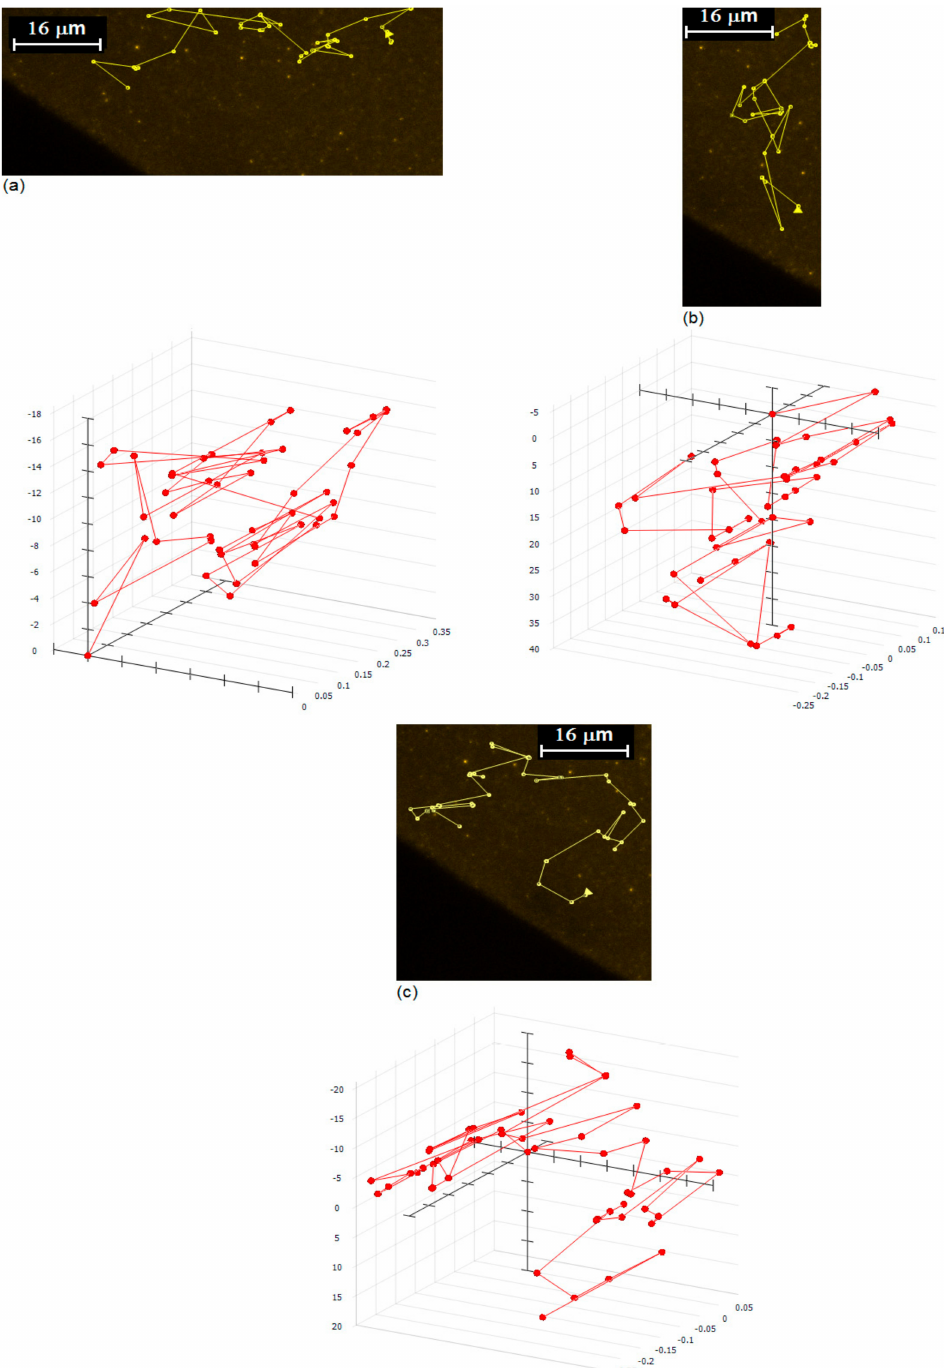
Figure 3. Two- (2D) and three-dimensional (3D) tracking of nanoparticles inside silver nanofluids. Dimensions of x , y , and z are in